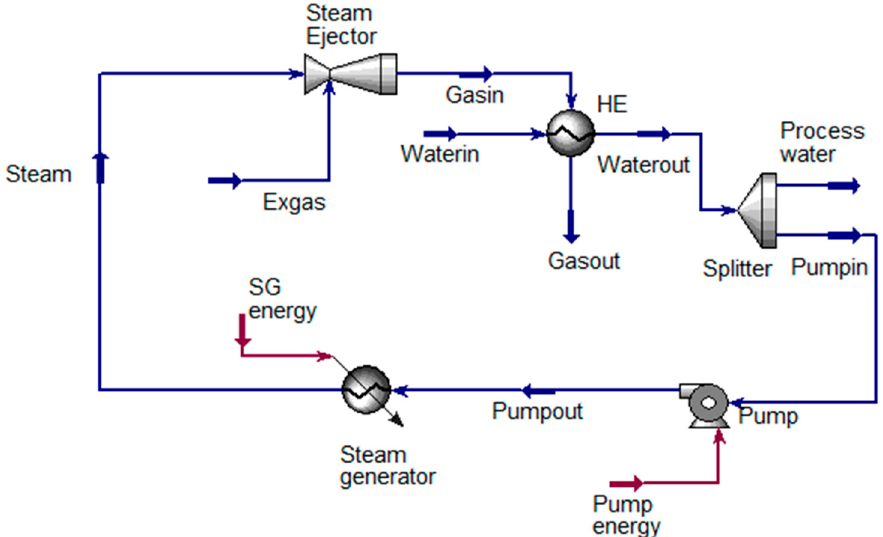
Figure 4. Flowsheet for the concept with the steam ejector.